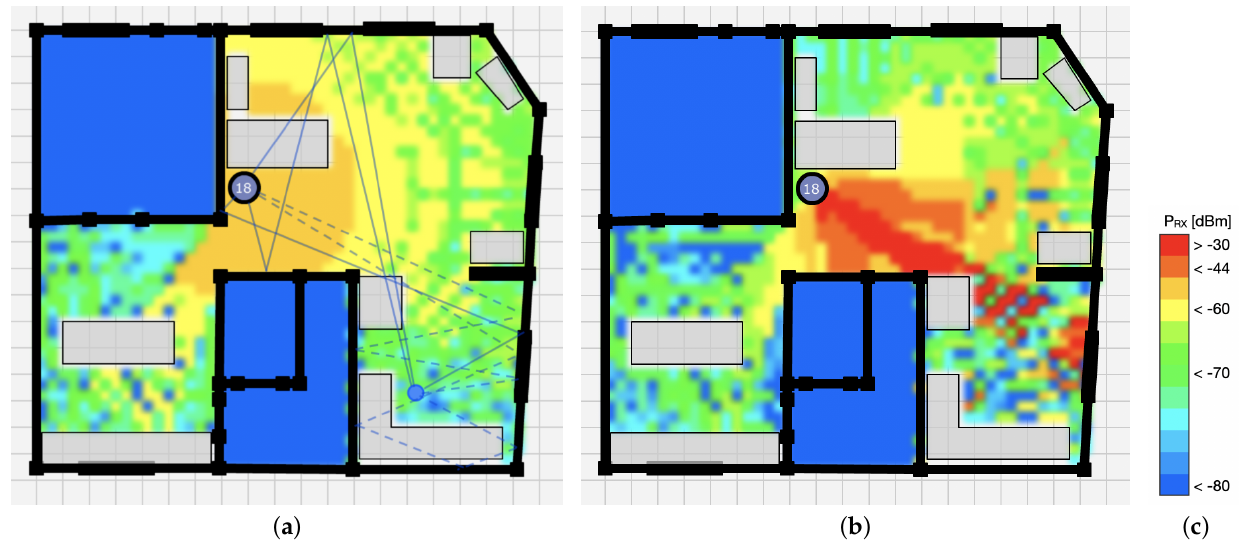
Figure 9. Received power prediction using ray-launching algorithm, for an access point location identical to the TX antenna location used in the NLOS1 path loss measurements. ( a ) Omnidirectional antenna with 3 dBi gain. Full lines represent the best reflected paths, and dashed lines represent paths with ceiling reflections. ( b ) Directional antenna with 23 dBi gain. ( c )